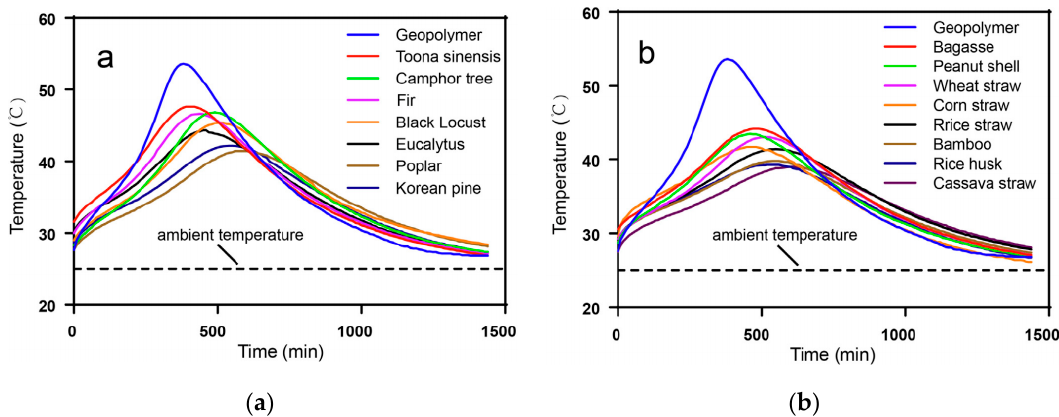
Figure 4. Curve of polymerization temperature of PF geopolymer with time. ( a ) Wood fiber; ( b ) Non ‐ wood fiber [65].